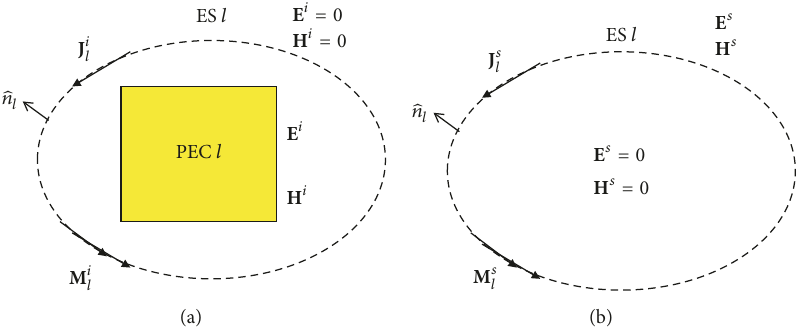
Figure 3: (a) Outside-in equivalence process. (b) Inside-out equivalence